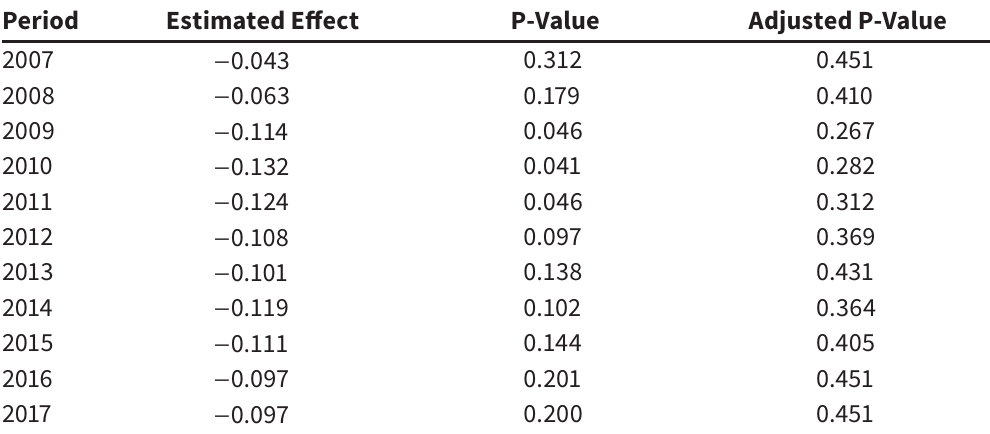
Treatment Effects and Significance for Log Total Employment/Population